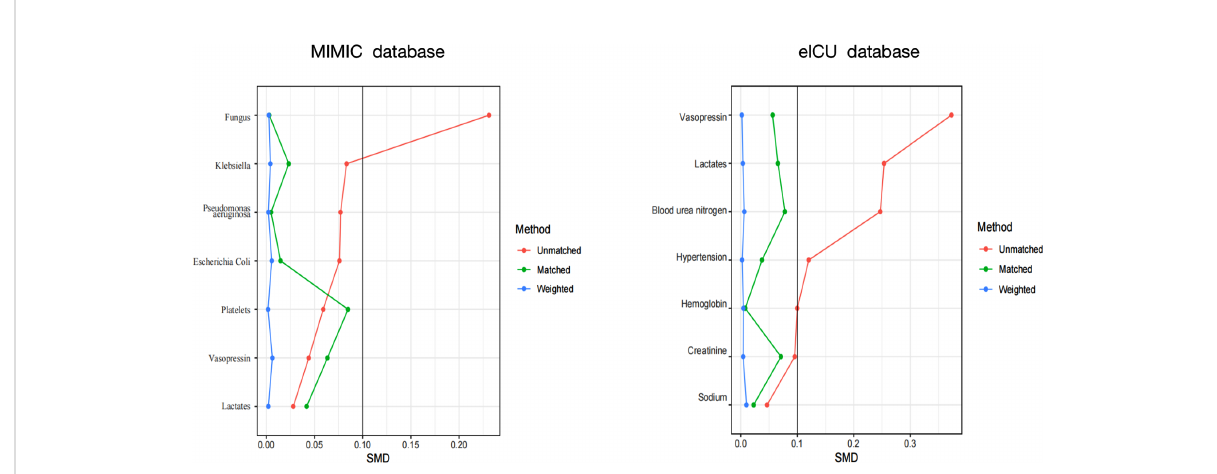
FIGURE 3 A SMD of the original cohort was compared with the SMD of the IPTW cohorts. SMD, standardized mean